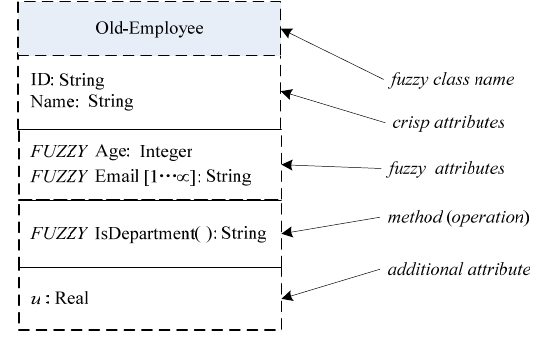
Fig. 2. Representation of a fuzzy generalization in a fuzzy UML